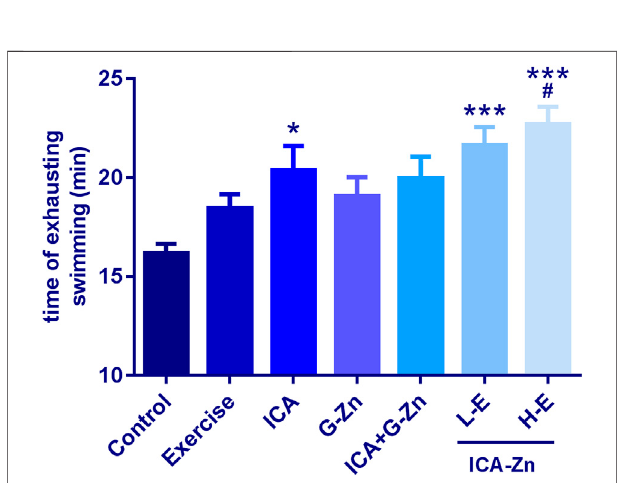
FIGURE3| Effectoficariin-zinconanti-fatigueofrats( n (cid:2) 8,mean ± SD). *p ＜ 0.01, ***p ＜ 0.001 vs. Control ； # p ＜ 0.05 vs. Exercise.